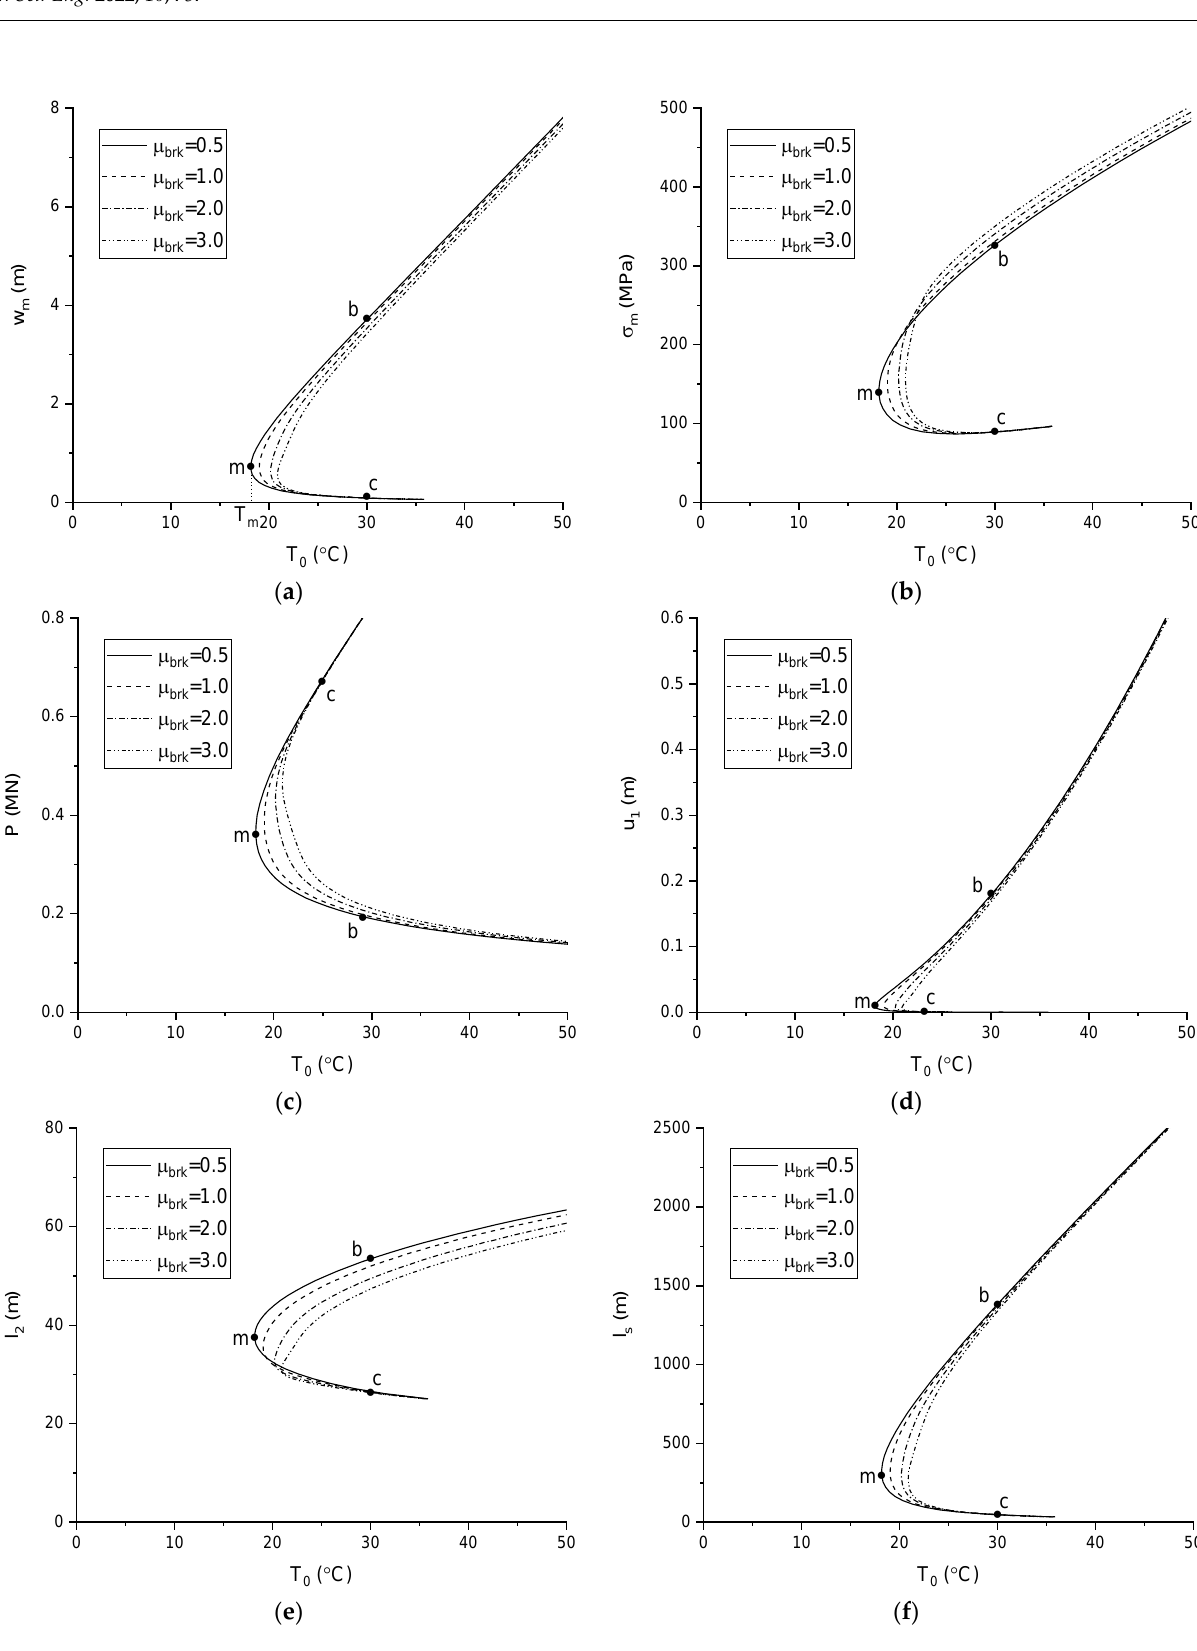
Figure 8. Influence of 𝜇 𝑏𝑟𝑘 on the buckling behaviour. ( a ) 𝑤 𝑚 . ( b ) 𝜎 𝑚 . ( c ) 𝑃 . ( d ) 𝑢 1 . ( e ) 𝑙 2 . ( f ) 𝑙 𝑠 ( 𝑣 𝑜𝑚 = 0.1 m, 𝜇 𝑠 = 0.1 ).